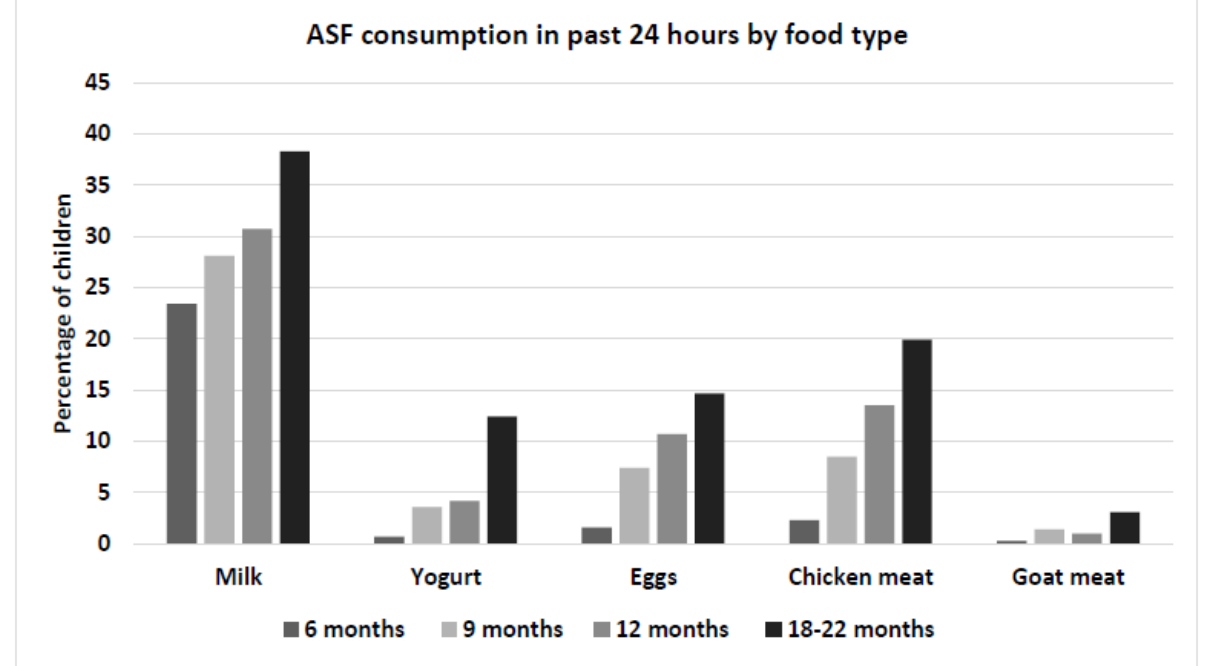
Figure A2. Type of ASF consumed by the child in the past 24 h. Table A1. Association of Total ASQ scores, HCZ, LAZ and daily consumption (Y/N) of all food groups.